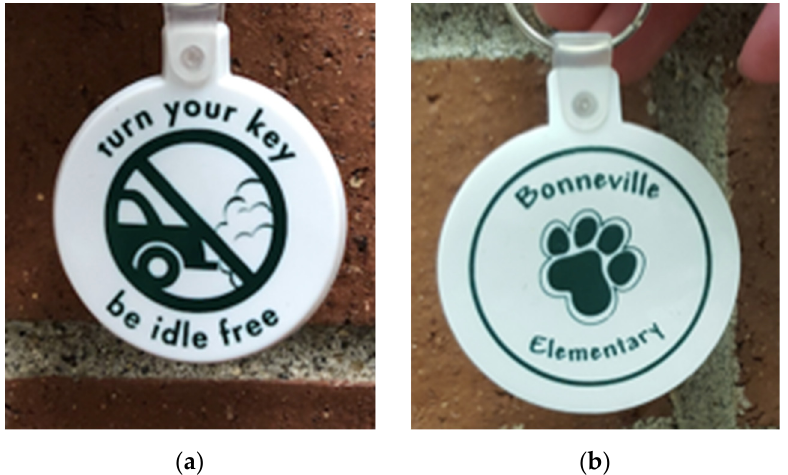
Figure 2. Both sides of keychains gifted to drivers not idling during morning drop-off and afternoon pick-up at Bonneville Elementary School: ( a ) “Turn your key be idle free” logo from Utah Clean Cities Coalition (https://utahcleancities.org/ [accessed on 1 December 2019]), courtesy of EPA Idle-Free Schools Toolkit for a Healthy School Environment; ( b ) Bonneville Elementary School logo.